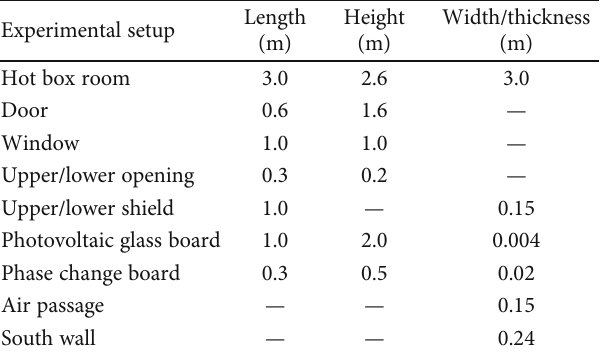
Figure 2: The test PV-PCM-Trombe wall system. Table 1: Dimensions of the experimental setup.